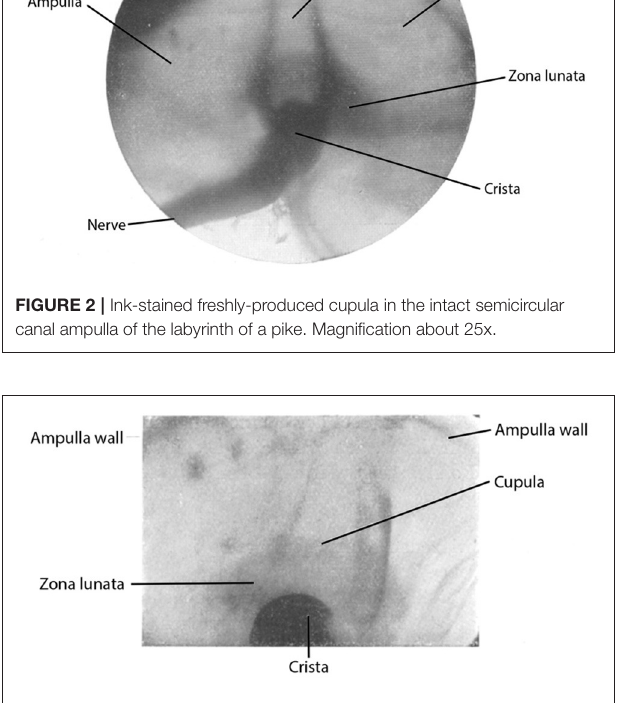
FIGURE 3 | Ink-stained cupula in the intact semicircular canal ampulla of the labyrinth of a pike (freshly-produced) at rest (the 4 edges of the cupula are particularly clearly stained).